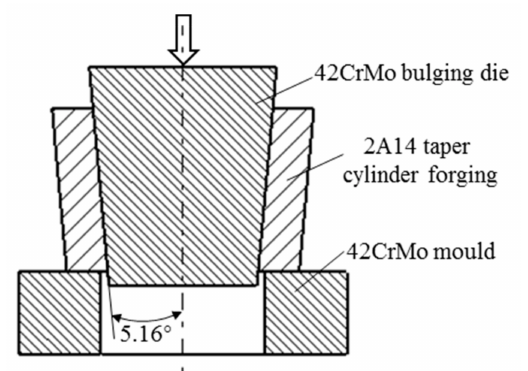
Figure 3. Schematic diagram of the cold bulging process.